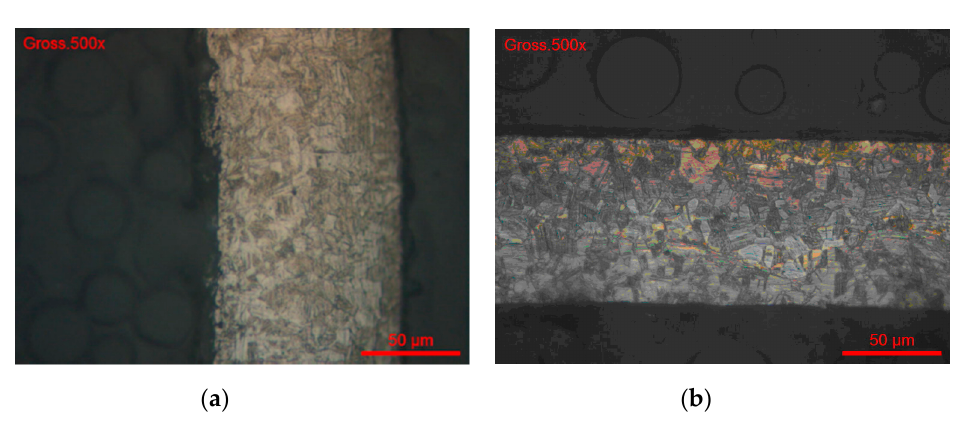
Figure 19. #Brut 1. Grain index (ASTM E112-13) G = 11. Grain index values are given in Table 9. Table 9. Grain index according to ASTM E112-13 [49]. Code